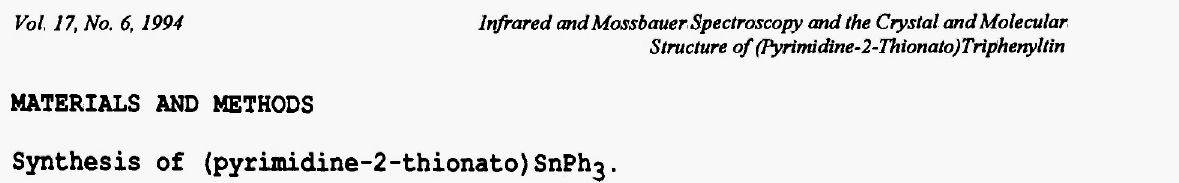
Table 1. Mossbauer data for Ph